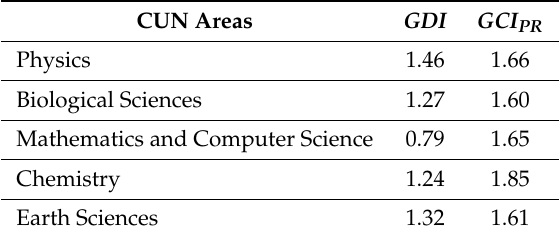
Table 12. GDI e GCI by in physics, biological sciences, mathematics and computer science, chemistry, and earth sciences (author’s elaboration of MIUR data,